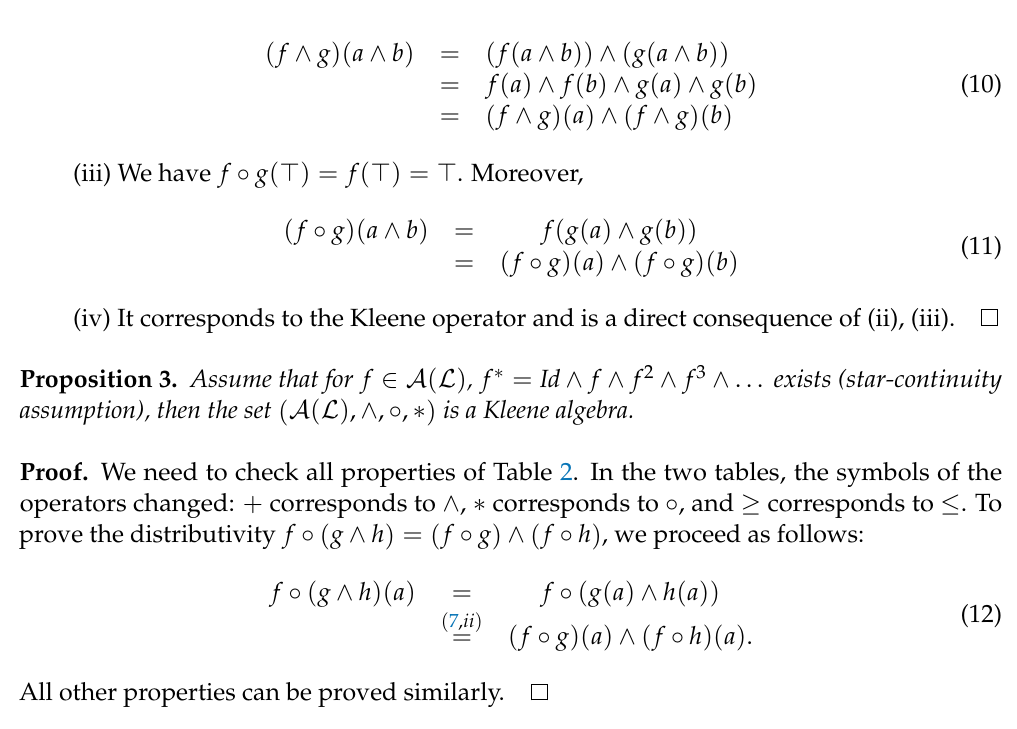
Table 2. The set of automorphisms forms a star-continuous Kleene algebra. Kleene Algebra ( A ( L ) , ∧ , ◦ , ∗